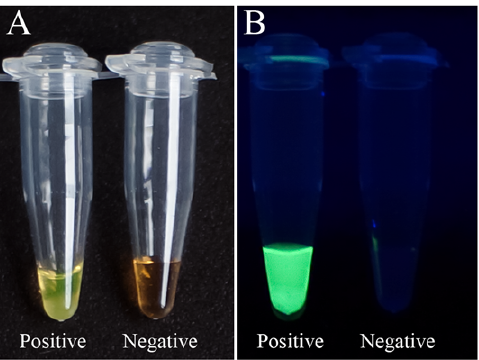
Figure 1. Visual detection of amplified LAMP products using SYBR green I. Addition of 1 m l of diluted SYBR green I to the reaction tube after LAMP reaction enables visible analysis of the results under natural light (Figure 1A) or UV irradiation (Figure 1B). The color changes from orange (negative reaction) to green (positive reaction) (Figure 1A) and bright fluorescence indicates a positive reaction (Figure 1B).